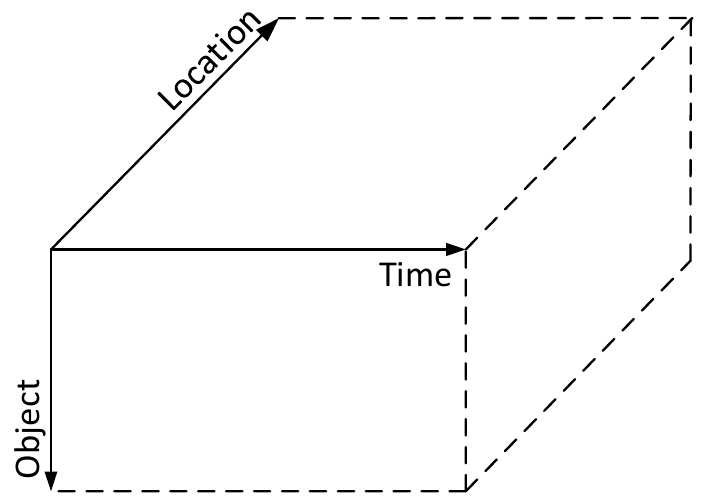
Figure 3. Graphic illustration of the third-order tensor with 3 modes representing object, location and time, respectively.